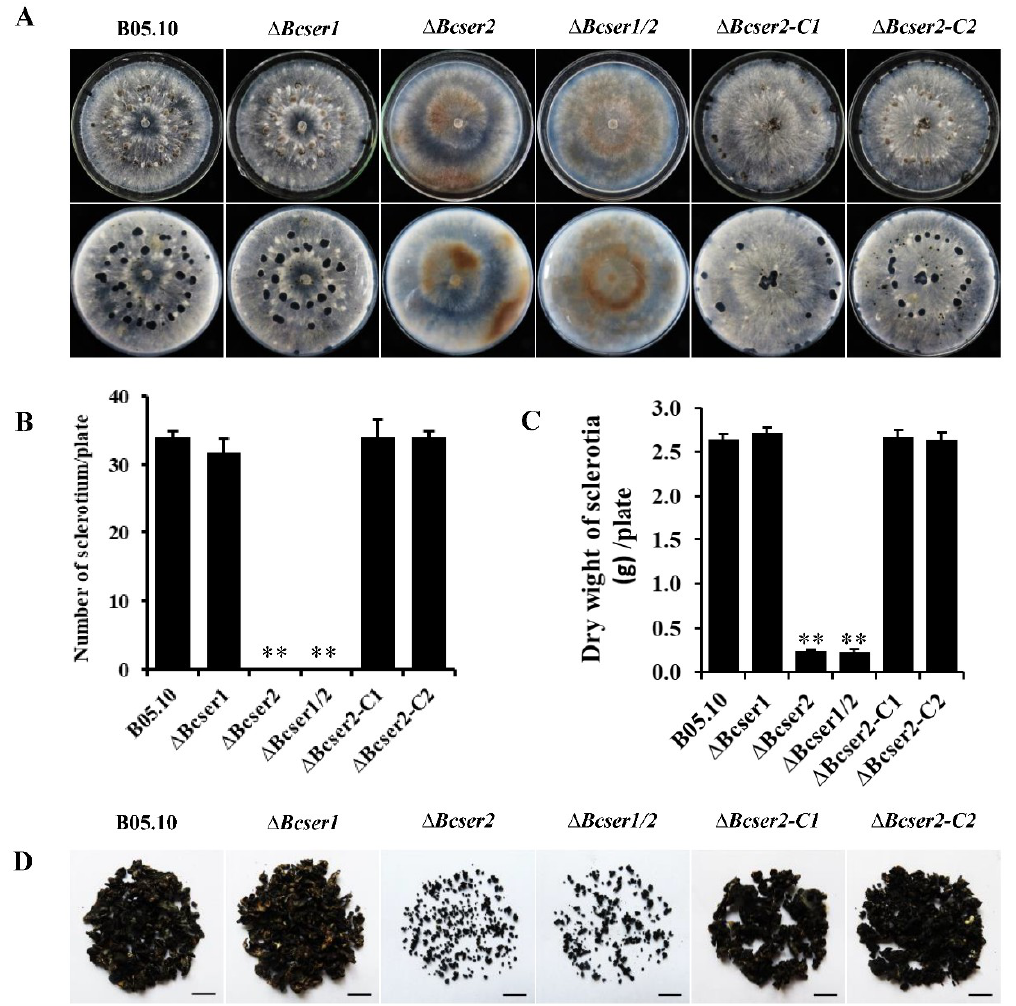
Figure 2. Effects of Bcser1 and Bcser2 deletion on sclerotial development of B. cinerea . ( A ) Phenotype of deletion mutants ∆Bcser1 , ∆Bcser2 and ∆Bcser1 / 2 , complemented mutants ∆Bcser2-C1 and ∆Bcser2-C2 , and wild-type strain B05.10 grown on potato dextrose agar (PDA) medium at 20 °C in complete darkness. The top row shows the front of the colony and the bottom row shows the back of the colony. Photographs were captured at 15 days post-inoculation (dpi). ( B ) Comparison of sclerotia number in strains growing on a PDA plate at 20 °C for 30 days in complete darkness. ( C ) The dry weight of ∆Bcser2 and ∆Bcser1 / 2 sclerotia grown on carrot cube medium are noticeably reduced compared to the WT and complemented strains. ( D ) Sclerotia yielded by wild-type strain B05.10 and all mutants per flask. Three independent replications were performed for each treatment. Bars indicate ±SE. Statistical significance is indicated in the graph (one-way ANOVA): **, p < 0.01.